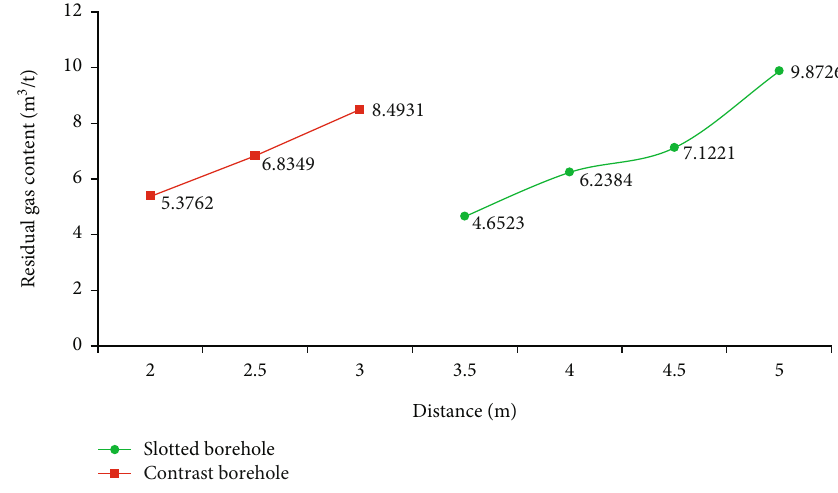
Figure 27: Determination results of residual gas content after 6 months of Table 5: Comparison of the amount of work between slotted drilling and comparative drilling. Contrast hole Slotted hole